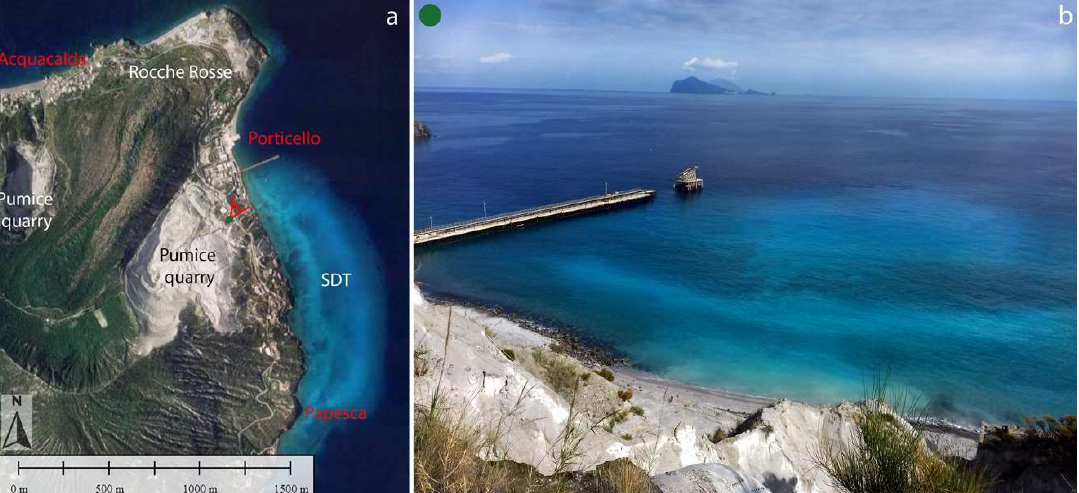
Figure 6. ( a ) Pumice exploitation plants in 2017. Note the location of the small pumice quarry upslope from the eastern edge of the Acquacalda beach; ( b ) the coast to the south of Porticello where some pumice excavation waste materials still reach the beach. The location of this picture is in Figure 1 through the respective colored dot; its point of view is indicated in ( a ).